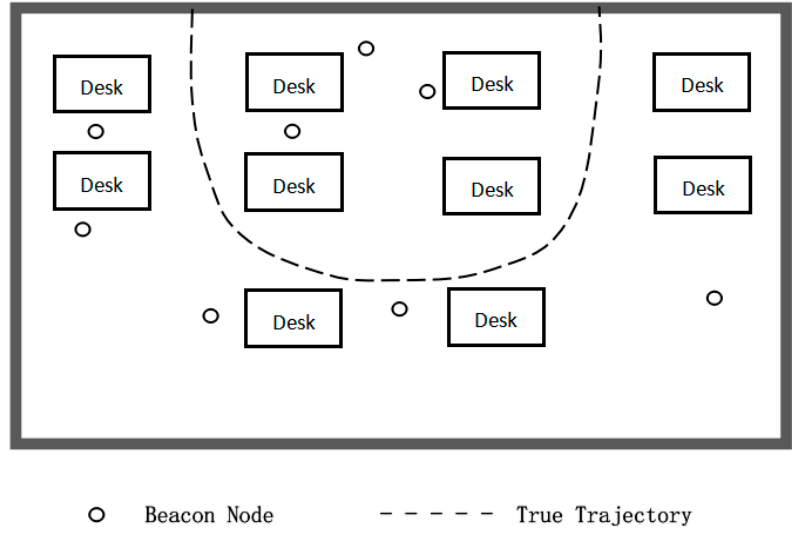
Figure 18. The floor plan of the second experimental environment.